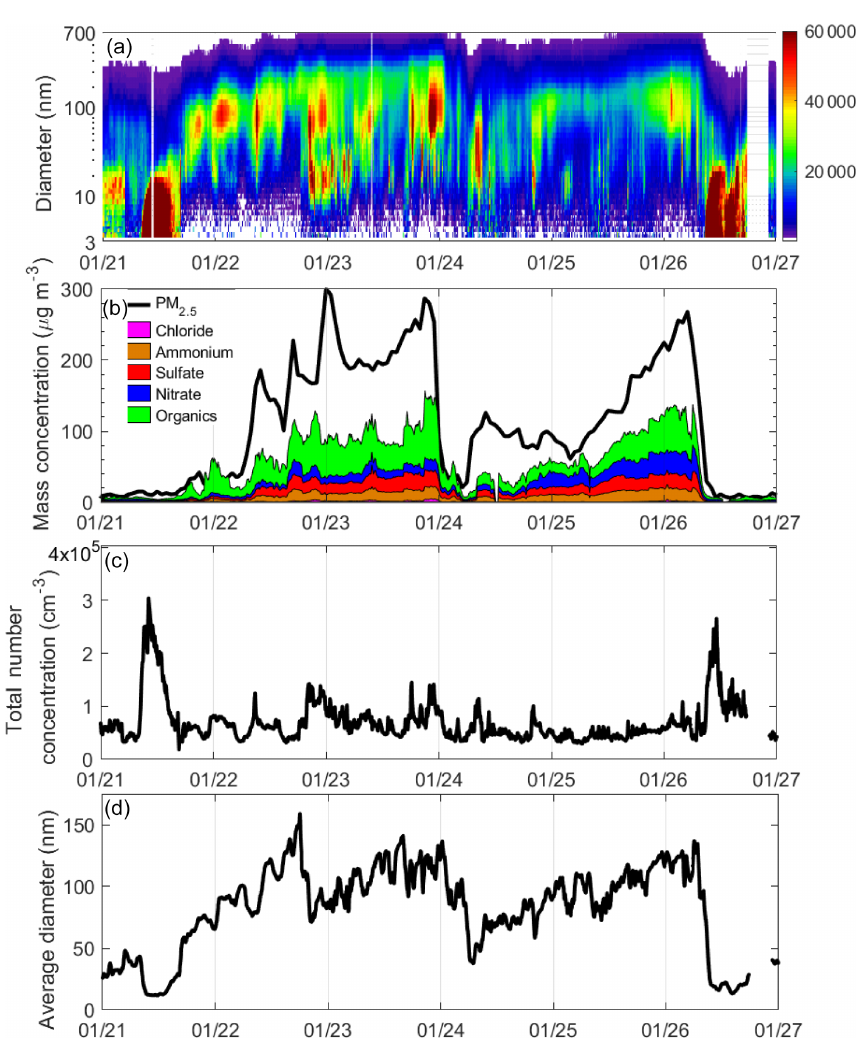
Figure 1. Temporal evolutions of (a) the number size distribution, (b) PM 2 . 5 mass concentration and chemical composition, (c) the total number concentration, and (d) the mean diameter between 21 and 27 January 2015. Dates in this figure are given in the month/day format.